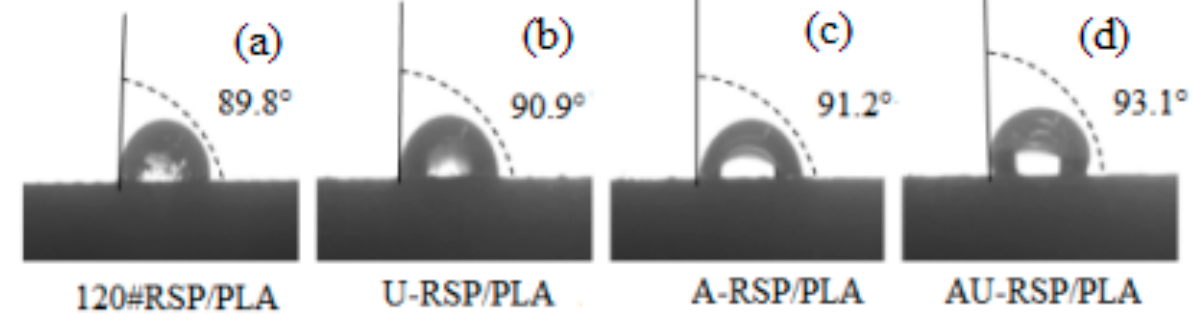
Figure 8. Co ntact angles of 3D-printed unmodified and modified RSP/PLA composites. Figure 8. Contact angles of 3D-printed unmodified and modified RSP/PLA